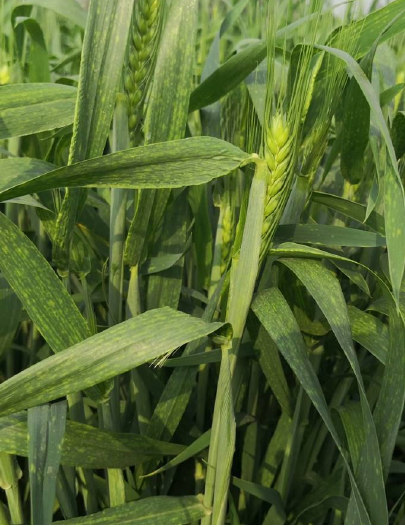
Figure 1. The leaf spots of Zhongkenuomai No.1 in the field environment.